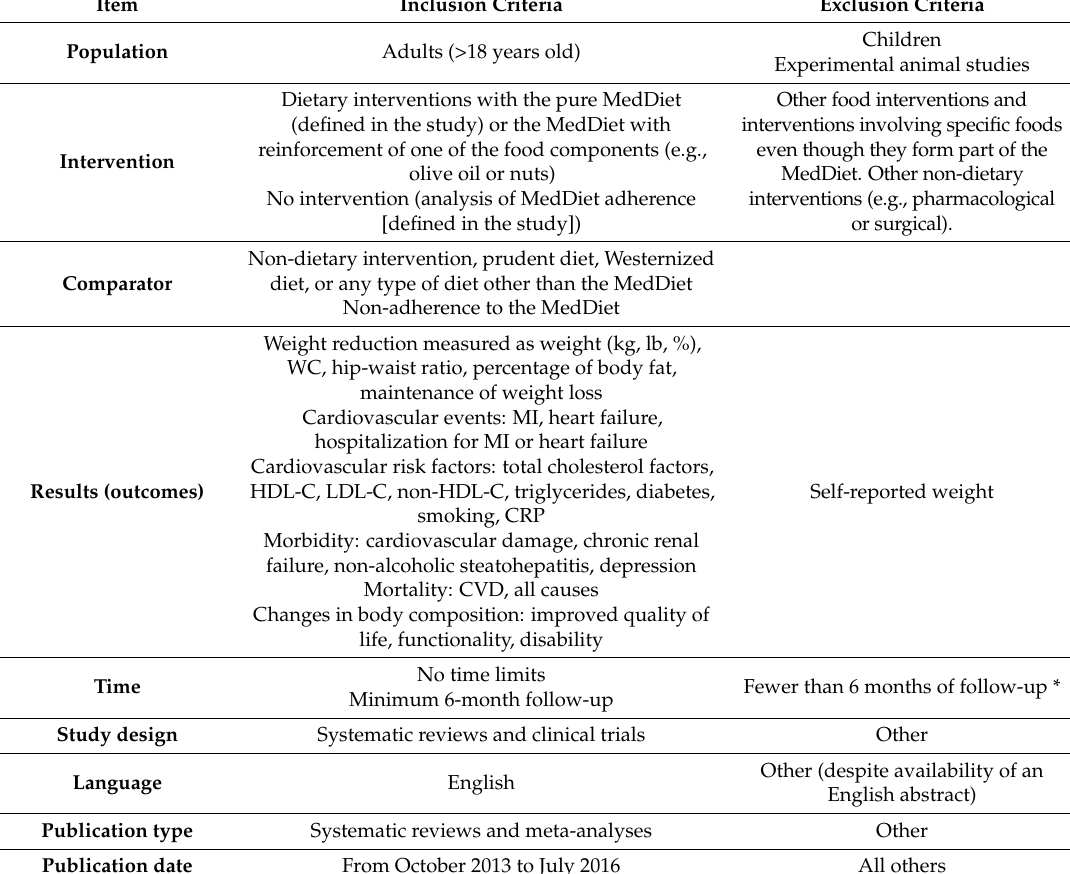
Table 2. Study selection criteria.